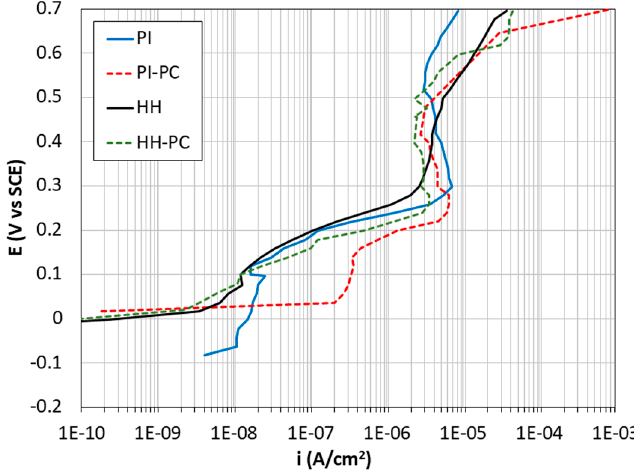
Figure 9. Anodic polarization curves obtained for S32304.